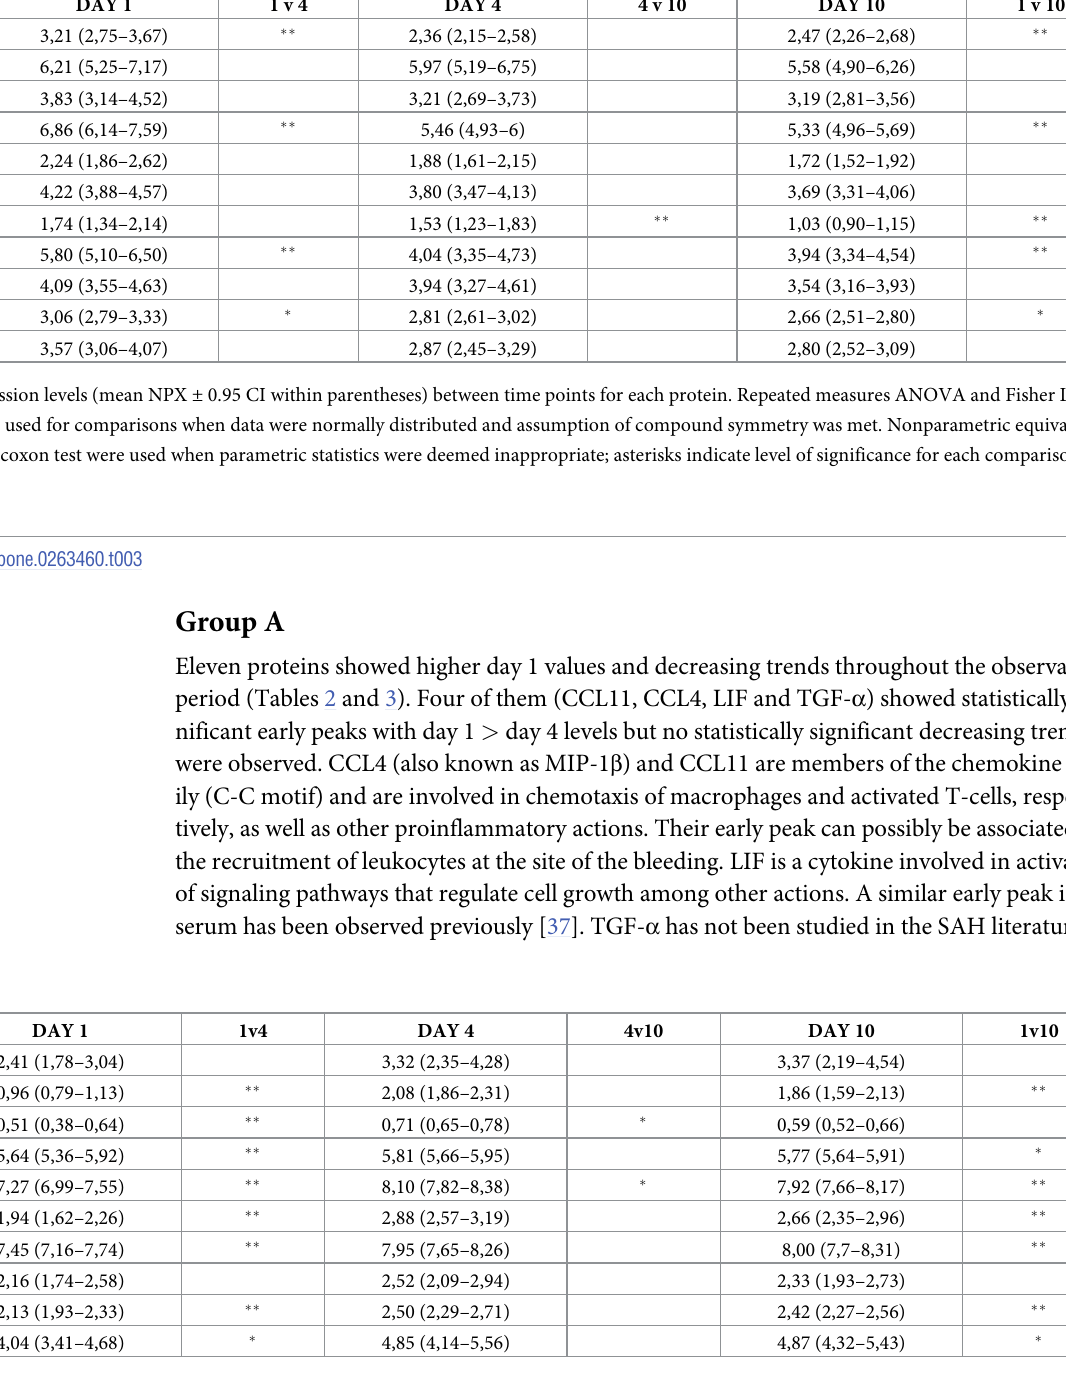
Comparison of protein expression levels (mean NPX ± 0.95 CI within parentheses) between time points for each protein. Repeated measures ANOVA and Fisher